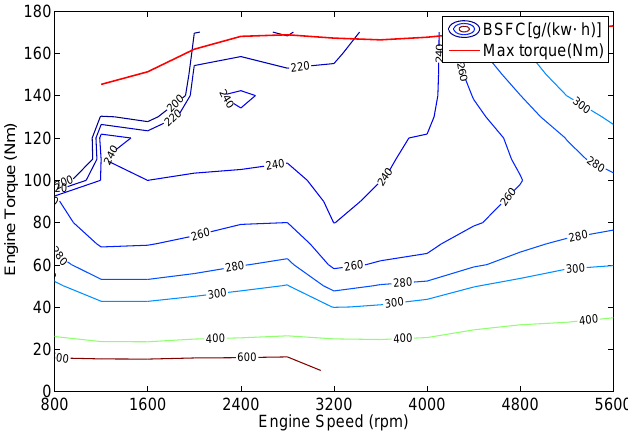
Figure 4. The fuel consumption efficiency map of ICE.